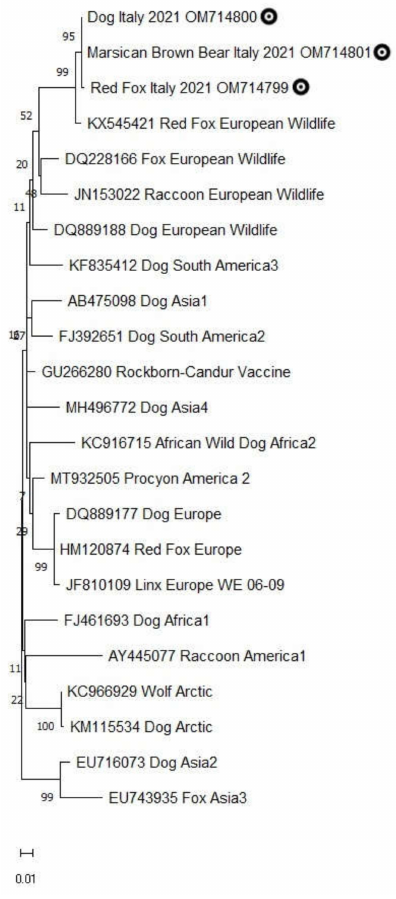
Figure 2. Maximum-likelihood tree obtained analyzing partial sequences of H gene from red fox, Marsican brown bear and dog and analogous sequences representative of main 14 lineages of CDV (Europe, Arctic, European Wildlife, Rockborn Vaccine, America 1 and America 2, Asia 1–4, Africa 1 and Wild Africa 2, South America 2 and South America 3). For each sequence, the GenBank Access number, the host species, and the lineage details are reported. The sequences under study are highlighted with a dark circle. Evolutionary analyses were conducted in MEGA11